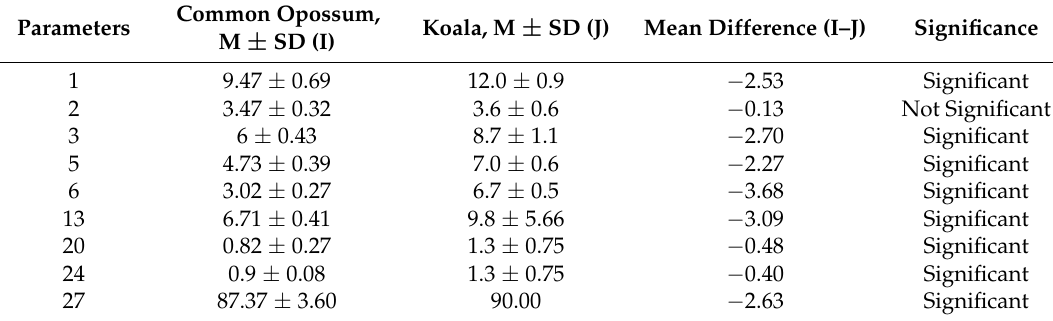
Table 4. One- sample test showing the differences between the common opossum and Koala.